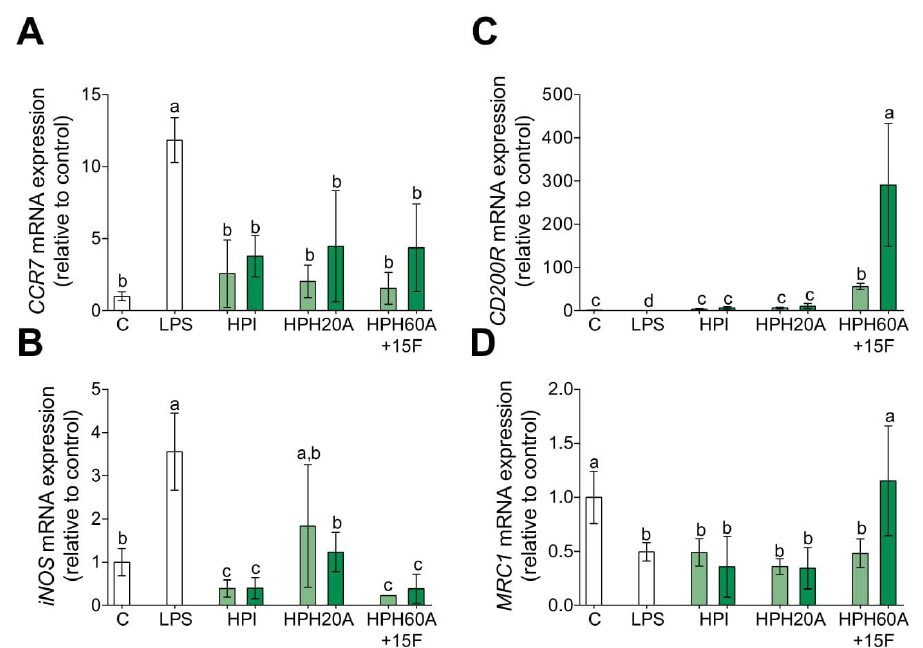
Figure 3. Effect of HPPs on macrophage polarization marker gene expression in LPS-stimulated primary human monocytes. Monocytes were activated with LPS (100 ng / mL) and then treated with HPI, HPH20A, and HPH60A15F at 50 (light green bar) and 100 (dark green bar) µ g / mL for 24 h. Relative mRNA expression levels of M1 markers, CCR7 ( A ) and iNOS ( B ), and M2 markers, CD200R ( C ) and MRC1 ( D ), were detected by real-time quantitative PCR. Data are presented as means ± SD ( n = 3) and the significantly different ( p < 0.05) are labeled with contrasting letters.